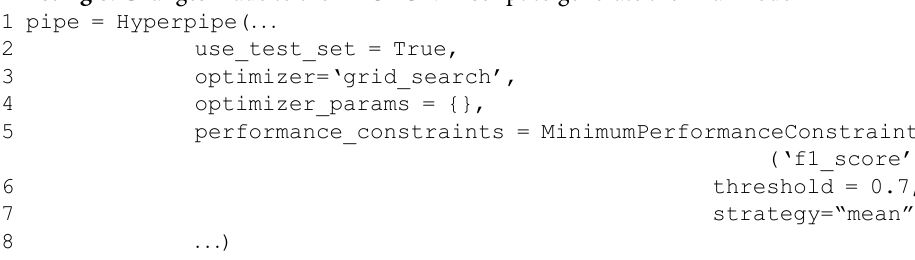
Table 2. Different estimator’s average best validation performance for the class balancing pipeline. Estimator